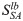
Schematic of steady-state nutrient acclimation.A)—Optimal transporter abundances n* (solid green line) lie at the porter limitation (blue shaded region) boundary. All points above and below this boundary fail to maximize growth rate; for all points below, the uptake rate is sub-maximal; for all points above, some transporters are unoccupied. Over an interval of bulk substrate concentrations S∞ ≤ S*, this boundary is met with diffusion limitation (orange shaded region), where the catalytic rate exceeds the encounter rate; as concentrations exceed S*, the porter limitation boundary transitions to an internal growth rate limit (yellow shaded region), where the catalytic rate exceeds the rate of some downstream reaction. B)—For smaller cells, or for transporters with slower kcat, membrane surface area limitation (a special case of porter limitation) may be encountered. In the interval bounded by SSAlb and SSAub, n* is constrained to nmax (black dashed line). C)—Growth rates of optimally acclimated cells (solid green line) follow the intersection of two limits: the diffusive limit (purple dashed line) and the internal growth limit μmaxG (black dashed line). These rate limits are, again, bisected by S* with a sharp transition. D)—If surface area limitation is encountered, growth rates in the interval SSAlb≤S∞≤SSAub follow a more gradual, hyperbolic transition from diffusion limitation to growth limitation.